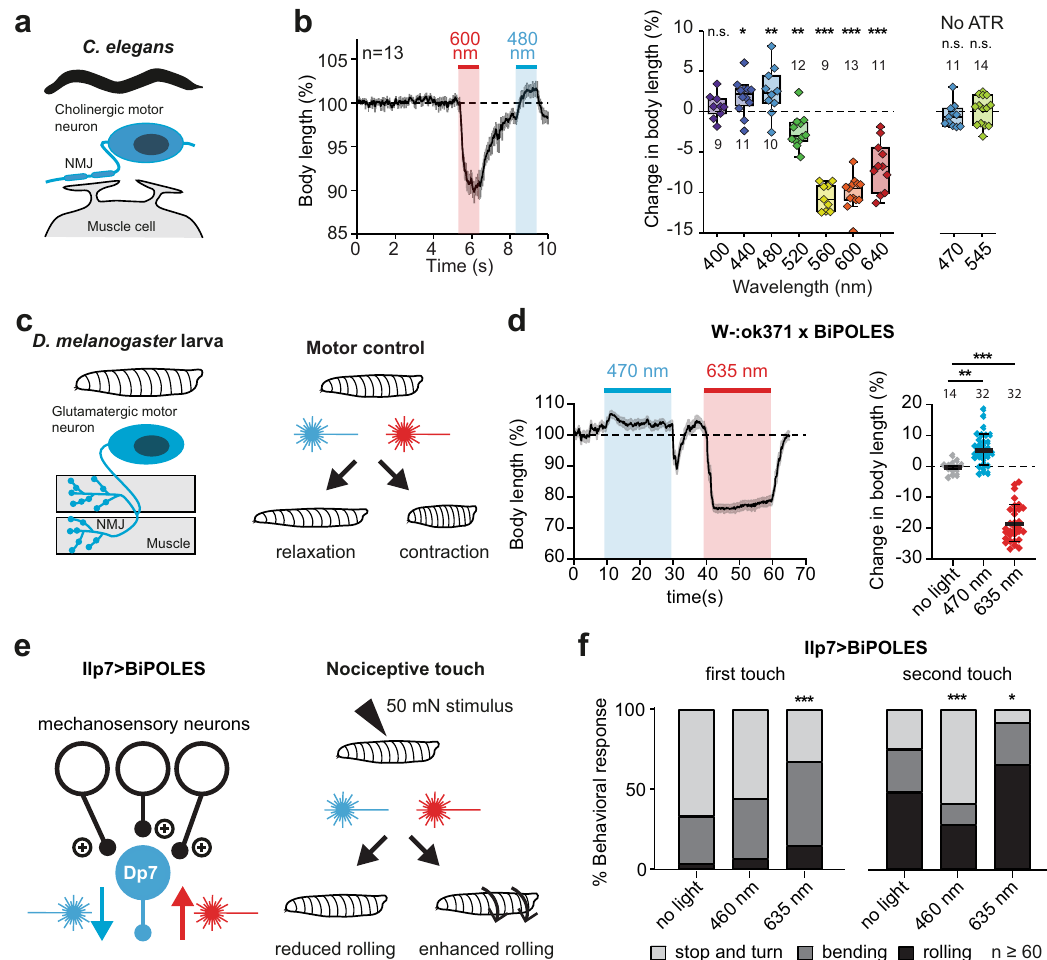
Fig. 6 BiPOLES allows bidirectional modulation of neuronal activity in C. elegans and D. melanogaster . a BiPOLES expressed in cholinergic neurons of C. elegans enables bidirectional control of body contraction and relaxation. Scheme of BiPOLES-expressing cholinergic motor neuron innervating a muscle cell. b Left: Temporal dynamics of relative changes in body length upon illumination with 600 and 480 nm light (mean ± SEM, 1.1 mW mm − 2 , n = 13 animals). Right: Spectral quanti fi cation of maximal change in body length, compared is the body length before to during light stimulation (seconds 0 – 4 vs. seconds 6 – 9, see Supplementary fi g. 12a; Box: median, 1st – 3rd quartile, whiskers: 1.5x interquartile range, two-way ANOVA (Sidak ’ s multiple comparisons test), p values: 400 nm ( n = 9 animals): 0.99, 440 nm ( n = 12): 0.049, 480 nm ( n = 10): 0.007, 520 nm ( n = 12): 0.002, 560 nm ( n = 9): <0.0001, 600 nm ( n = 13): <0.0001, 640 nm ( n = 11): <0.0001, no ATR 470 nm ( n = 11): 0.24, no ATR 545 nm ( n = 14): 0.78). Experiments in absence of all- trans -retinal were done with 470/40 nm and 545/30 nm bandpass fi lters. c BiPOLES expressed in glutamatergic neurons of D. melanogaster larvae enables bidirectional control of body contraction and relaxation. Scheme of BiPOLES-expressing glutamatergic motor neuron innervating muscle fi bers. d Left: Temporal dynamics of relative changes in body length upon illumination with 470 (17 µ W mm − 2 , n = 32 animals) and 635 nm light (25 µ W mm − 2 , n = 32). Right: Quanti fi cation of maximal change in body length (mean ± SEM, no light = 14, 470 nm = 32, 635 nm = 32, ** p = 0.0152, *** p = 0.0005, one-way ANOVA with Dunnett ’ s multiple comparisons test). e BiPOLES-dependent manipulation of Dp7 neurons in the Drosophila larval brain (Ilp7-Gal4>UAS-BiPOLES) and the resulting change in nociceptive escape behavior following a 50 mN noxious touch. f Behavioral response after the fi rst and second mechanical stimulus under blue light (470 nm, 1.7 mW mm − 2 ) or red light (635 nm, 2.5 mW mm − 2 ) illumination compared to no light. n = 61 animals * p = 0.034, *** p = 0.0005 ( fi rst touch) and 0.0007 (second touch), Χ 2